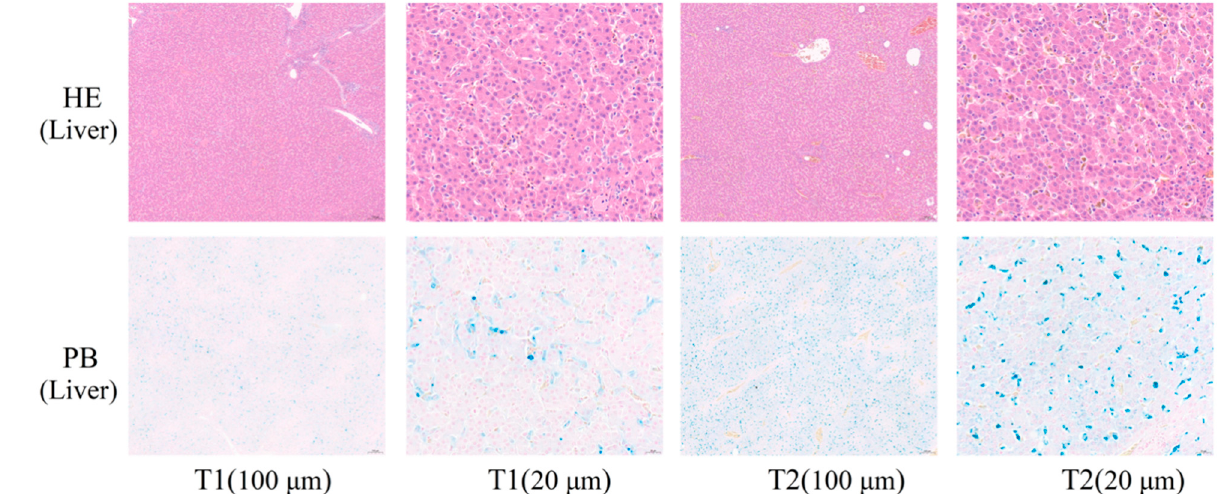
Figure 1. Morphological observations of broilers hepatic and chicken breasts. T1: not transported group (control); T2: transported group (for 4 h). HE, hematoxylin, and eosin staining; PB, Prussian blue staining; HE and PB staining, cells, and myogenic fibers are shown in red, and iron ions are shown in blue. The scale bar is 100 μ m and 20 μ m.